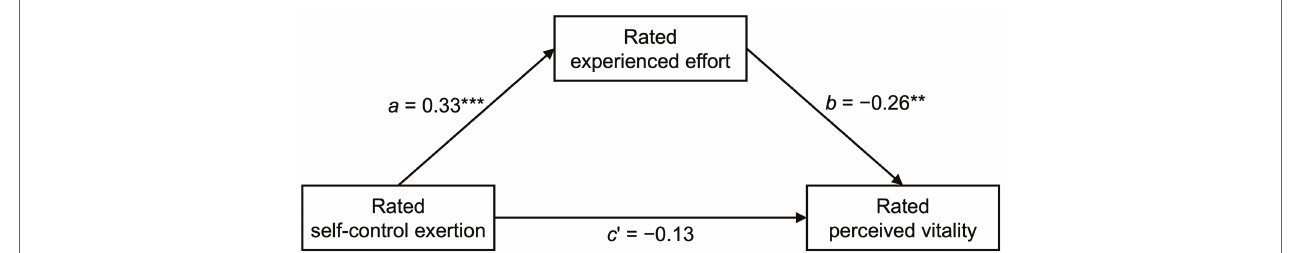
FIGURE 2 | Mediation of the direct effect ( c ’) of rated self-control exertion on rated perceived vitality via the mediator rated experienced effort in the self-control condition (Study 1). Depicted are the standardized beta weights. N = 133. * p < 0.05; ** p < 0.01; *** p < 0.001.